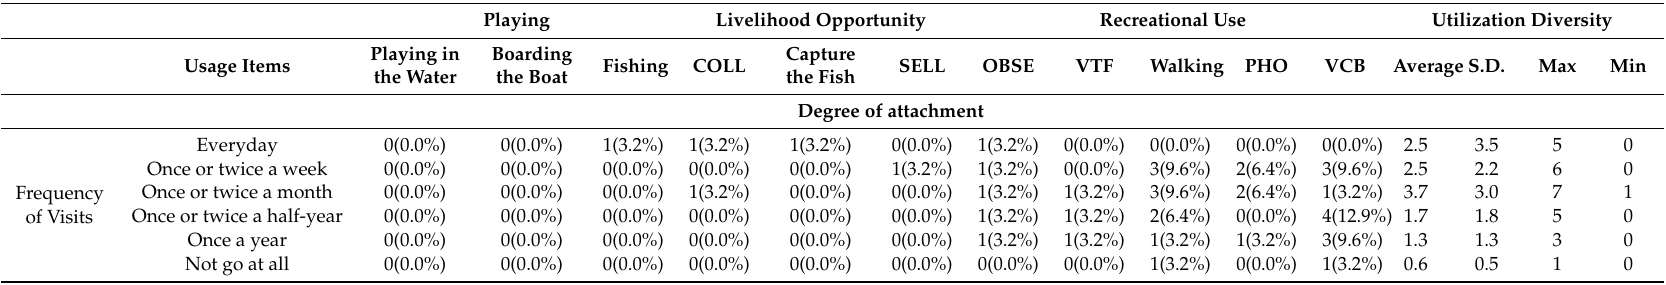
Table A5. The extent of attachment to the Fukushima-gata lagoon and actual use situation of the Fukushima-gata lagoon after reclamation project (n =